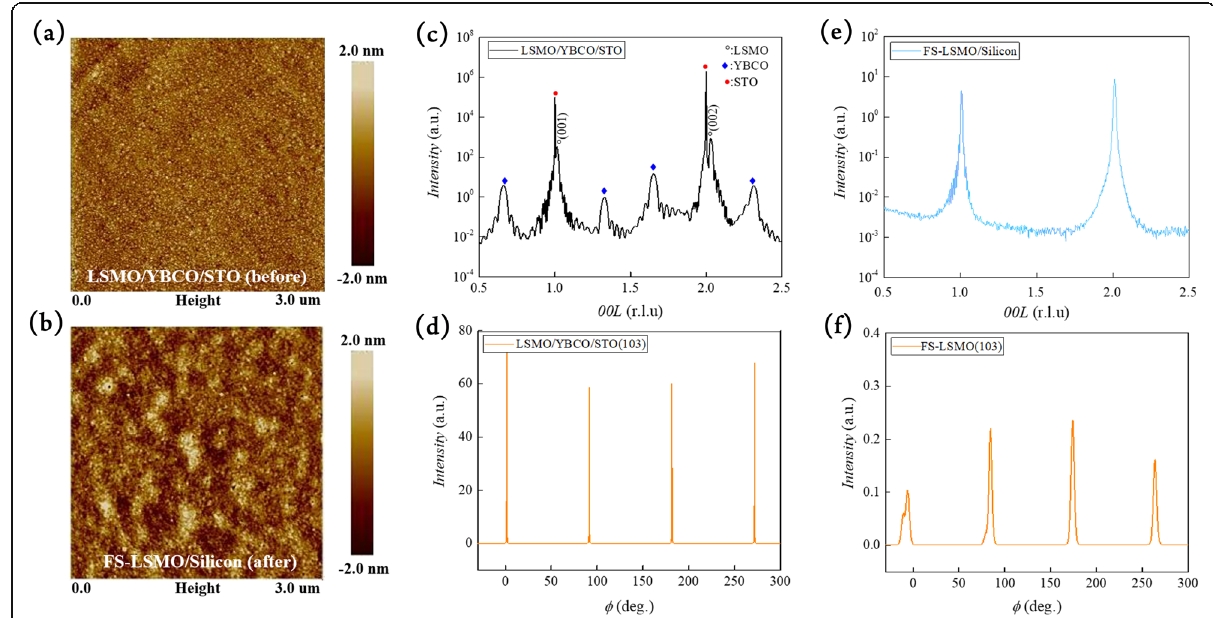
Fig. 2 AFM topography images of LSMO a before and b after freestanding. c XRD normal scan of LSMO/YBCO/STO heterostructure. d Phi-scan around LSMO (103) plane of as-grown LSMO. e XRD normal scan of freestanding LSMO and f Phi-scan around freestanding LSMO (103)